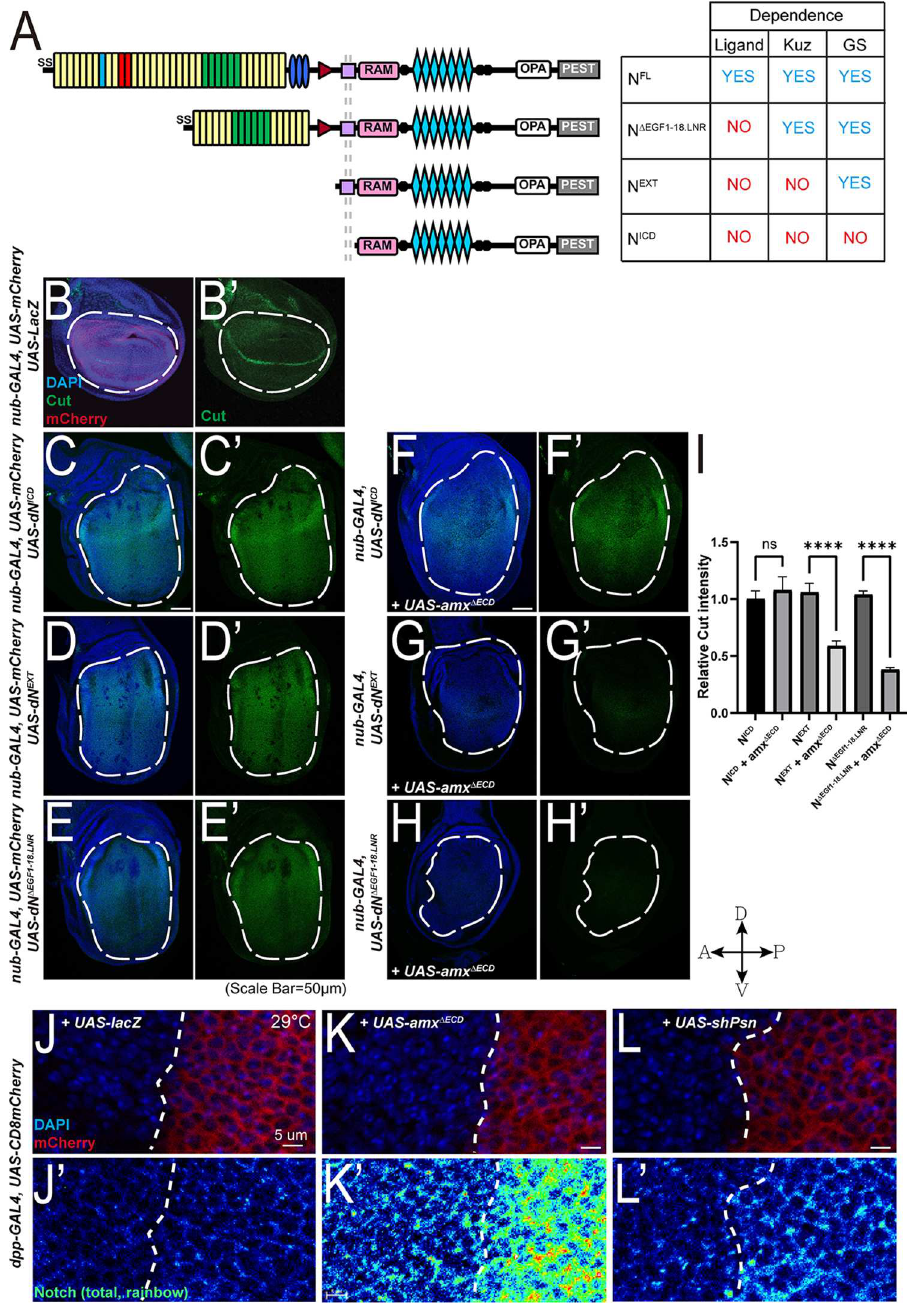
Fig 5. Genetic epistasis experiments place truncated Amx at the γ -secretase cleavage step of Notch activation. (A) Schematics and characteristics of Notch proteins made from each UAS-Notch transgenes that were generated for this study. Full-length Notch (N FL ) requires ligand binding and processing by Kuzbanian (Kuz) and γ -secretase (GS) for activation. Notch with EGF repeats and LNR domains removed (N Δ EGF1-18.LNR ) is not dependent on ligands but are dependent on both Kuz and GS for activation. Notch with an extracellular truncation (N EXT ) is dependent only on GS for activation. The Notch intracellular domain (N ICD ) is constitutively active. (B) Cut (green) along the dorsoventral midline within the wing pouch [marked by nub-GAL4 UAS-mCherry (red), outlined by a white dash oval) is induced by Notch signaling. LacZ is expressed as a neutral protein. (C-E) Expression of Notch constructs leads to increase in Cut expression, quantified in (I). (F) Co-overexpression of 3xHA::Amx Δ ECD has no effect of N ICD mediated increases in Cut expression (F’, I). (G-H) 3xHA::Amx Δ ECD expression suppresses the effects of N Δ EGF1-18.LNR and N EXT on Cut expression (G’, H’, I). t-test. � = p < 0.05. ���� = p < 0.0001. Error bars show SEM. (J-L) Overexpression of